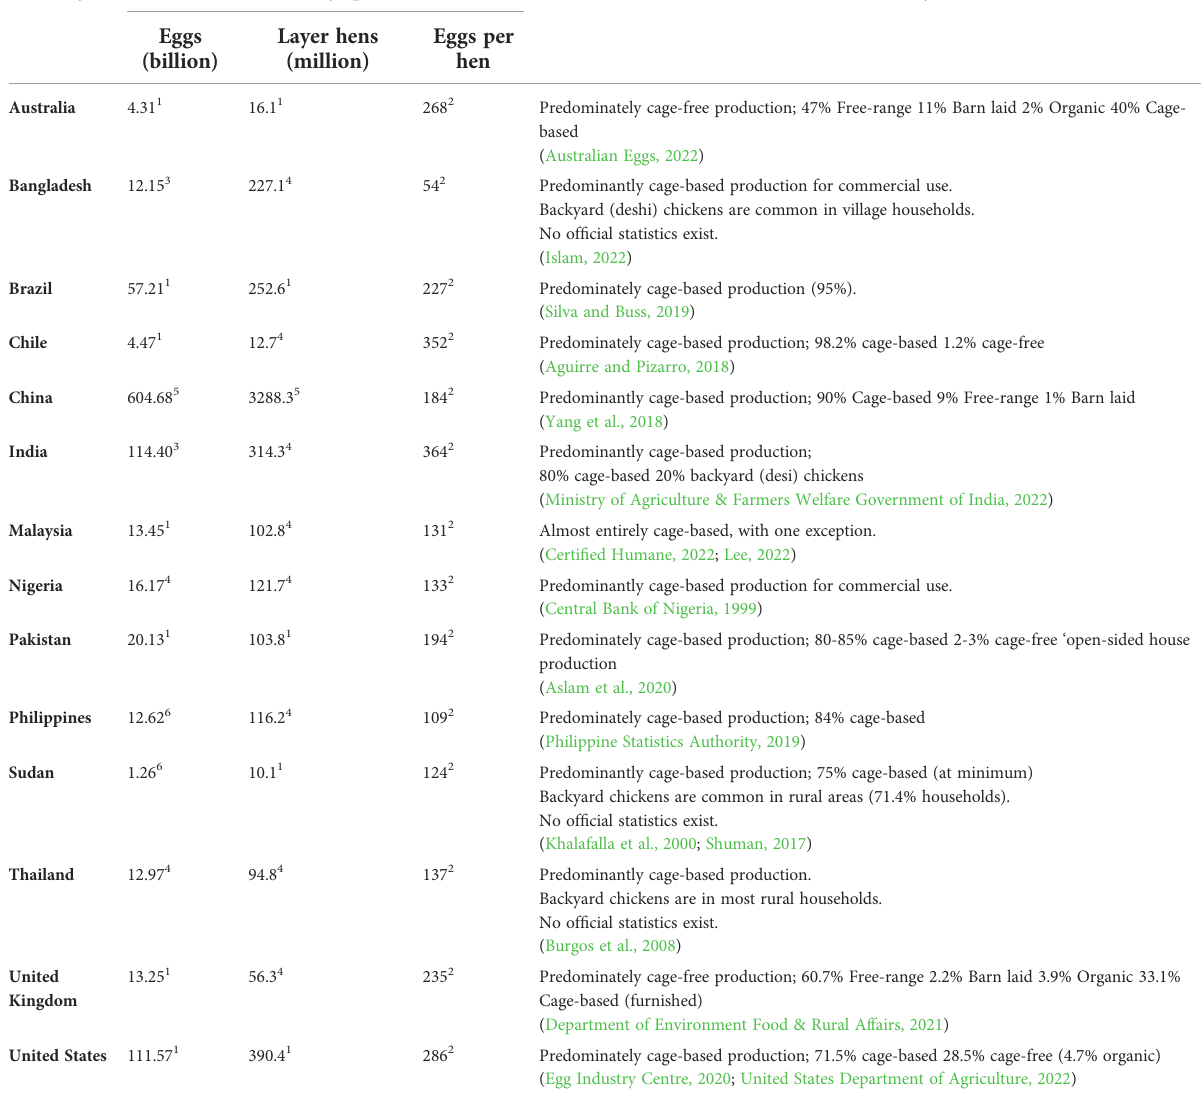
TABLE 3 Egg production industry size and systems by country - 2020. Country Size of Industry (per